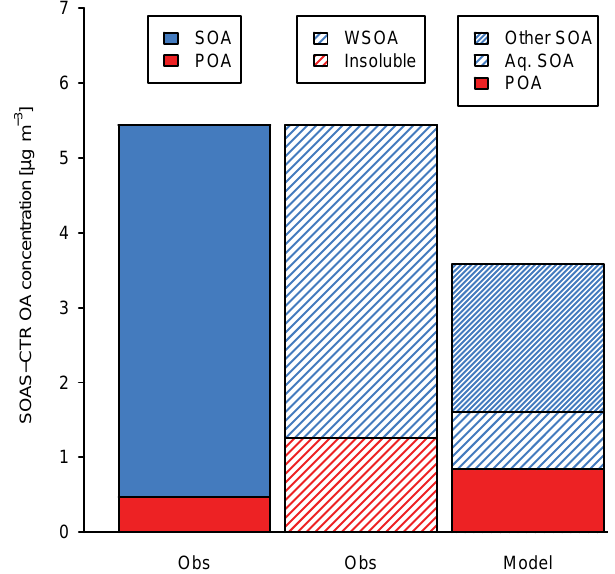
Figure 1. Contribution of POA (observed biomass burning OA, BBOA; Xu et al., 2015a), SOA, water-soluble OA (estimated as 2.1 × WSOC from the Particle-into-Liquid Sampler (PiLS); Sulli- van et al., 2004), and aqueous (aq.) SOA (model only) to total OA during June 2013 observed at CTR during SOAS and modeled by standard CMAQ. Insoluble OA is the difference between measured total OA and water-soluble OA. Modeled “other SOA” is formed via partitioning to a dry organic